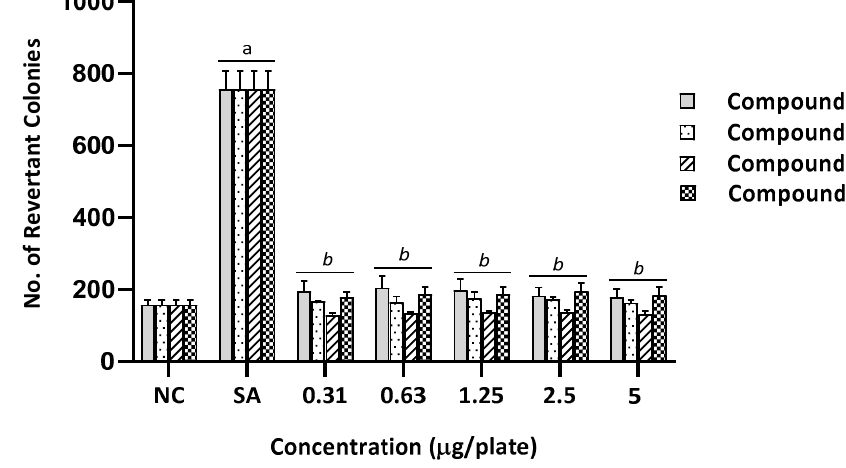
Figure 5. The number of revertant colonies of TA100 strain of Salmonella typhimurium treated with different concentration of benzimidazole derivatives (1–4) in the absence of metabolic activation system ( − S9). NC, Negative control (1% of DMSO in PBS); SA (sodium azide), Positive control (5 µg/plate). Values were expressed as mean ± SEM of three independent experiments. a, significantly different ( p < 0.05) from the NC group; b , significantly different ( p < 0.05) from the positive control group (SA).